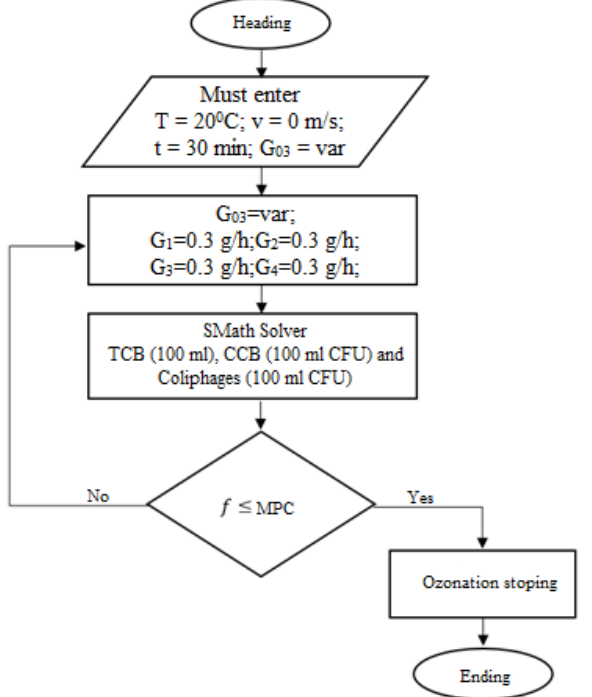
Figure 7. Algorithm of the process of destruction of harmful microorganisms in water.